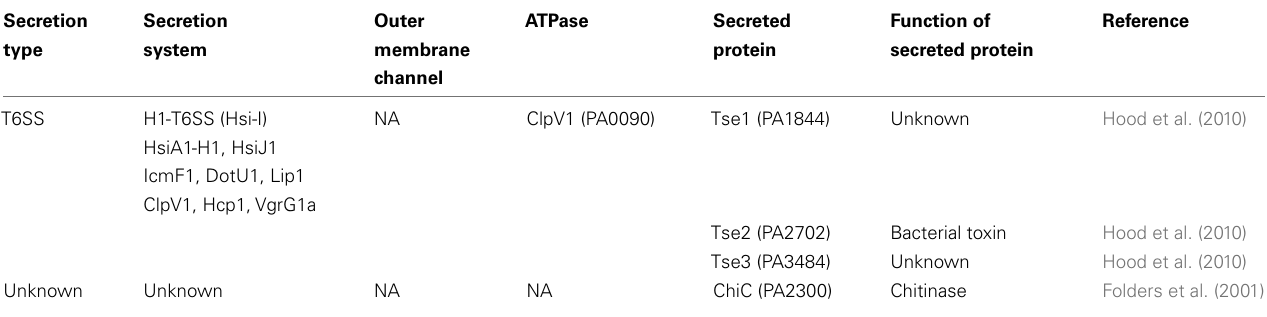
Table 1 | Characterized secretion systems and secreted proteins in P. aeruginosa